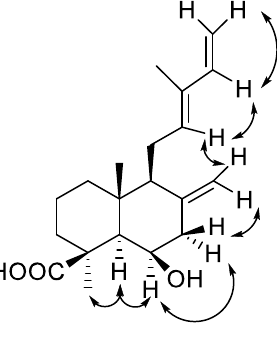
Figure 4. Key NOESY interactions observed for compound 2 .